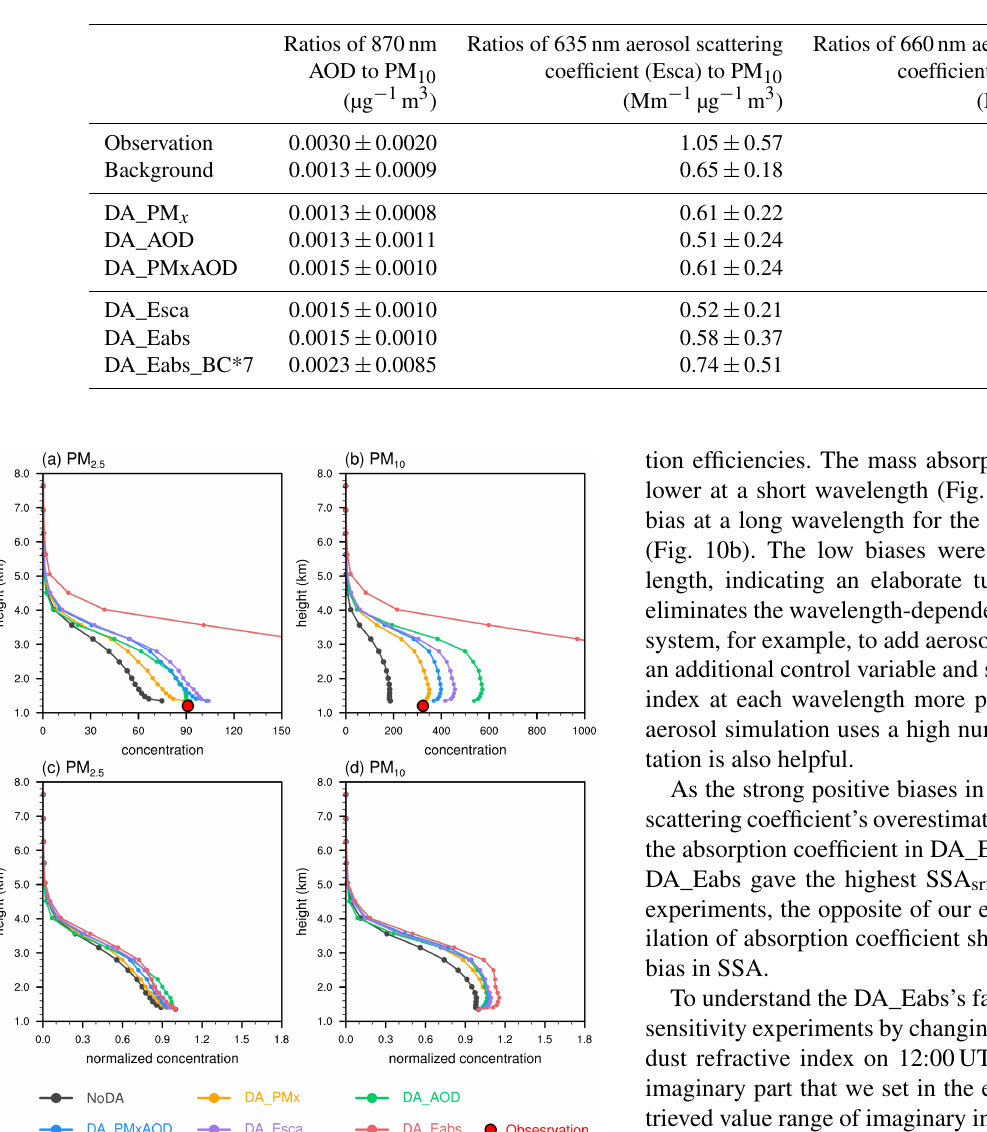
Table 4. The ratios of AOD, aerosol scattering or absorption coefficient to PM 10 concentration (mean ± standard deviation) in the observa- tions, the model background data, and the DA analyses.